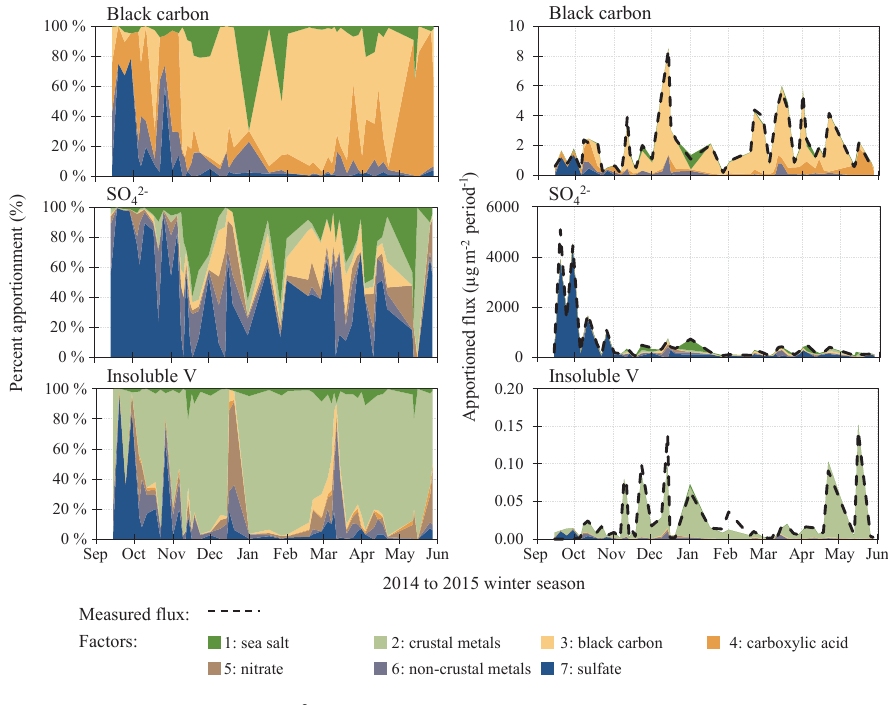
Figure 4. Percent and total apportionment of BC, SO 2 −